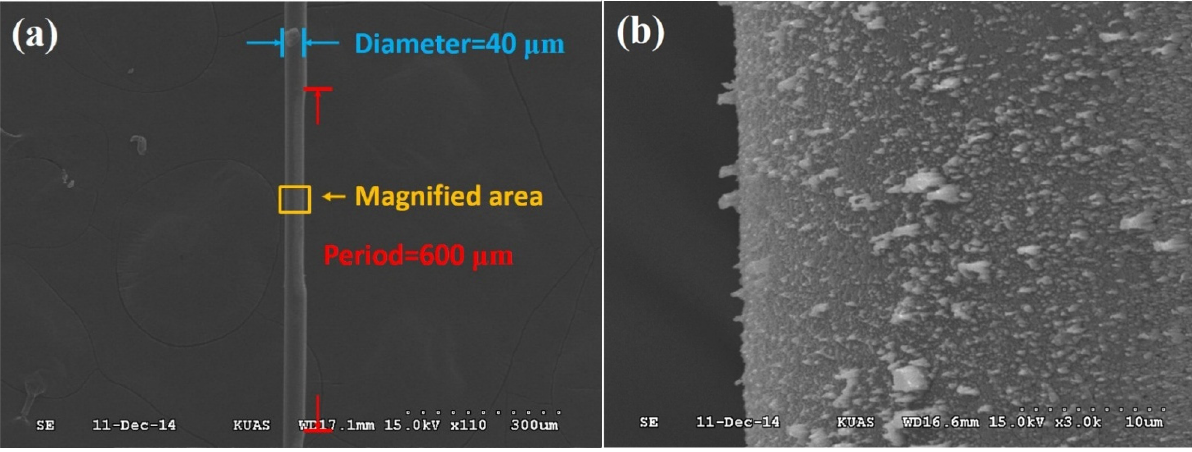
Figure 2. ( a ) SEM image of the NLPFG sensor with the surface needle nanostructure; ( b ) High-magnification SEM images surface needle